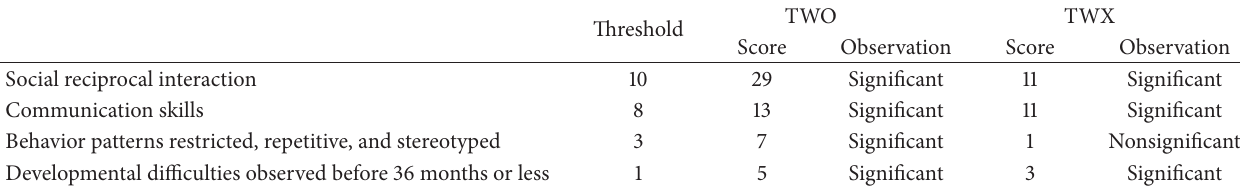
Table 1: Comparative evaluation of TWO and TWX according to Autism Diagnostic Interview-Revised (ADI-R).